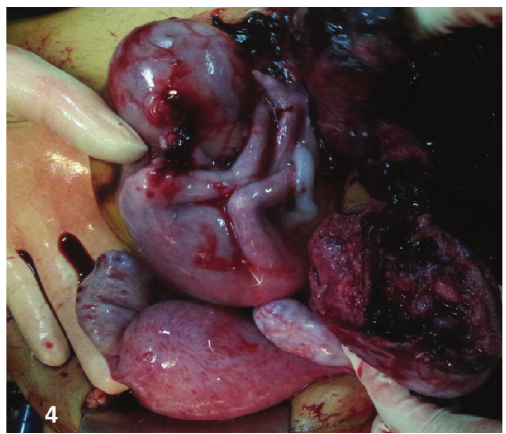
Figure 4: Unicornuate uterus with rupture of pregnant noncom- municating rudimentary horn, with fetus lying outside the uterus (intraoperative).